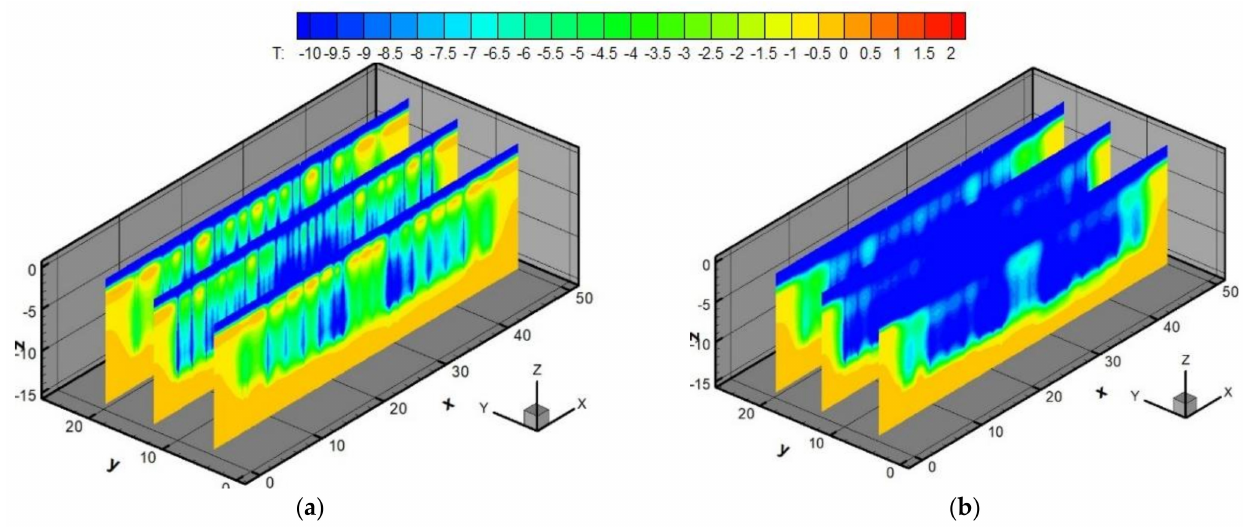
Figure 5. Temperature fields in the { x , z } plane under Building I in December 2020 ( a ) and January 2021 ( b ) in the vertical